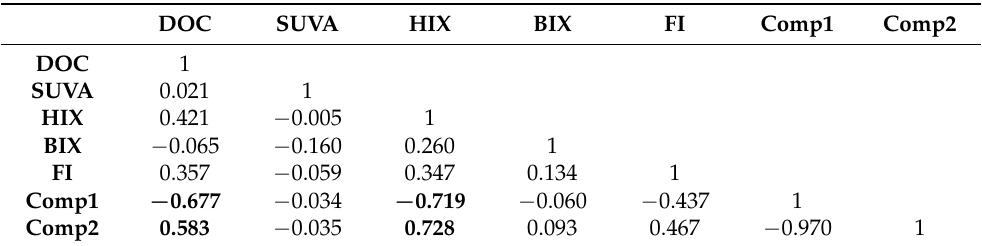
Table 1. Spearman’s correlation coefficient matrix of the calculated ranks of observed and calculated parameters. Values in bold indicate significant correlation. DOC SUVA HIX BIX FI Comp1 Comp2 DOC 1 SUVA 0.021 1 HIX 0.421 − 0.005 1 BIX − 0.065 − 0.160